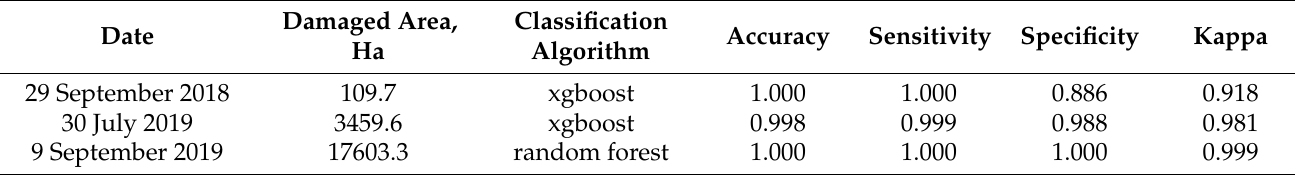
Table 2. Statistical indicators of the